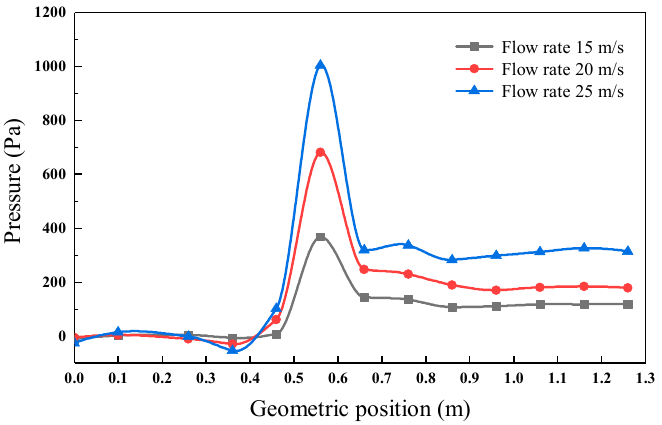
Figure 5. Effect of flow rate on the axial pressure distribution of the cylindrical cyclone.